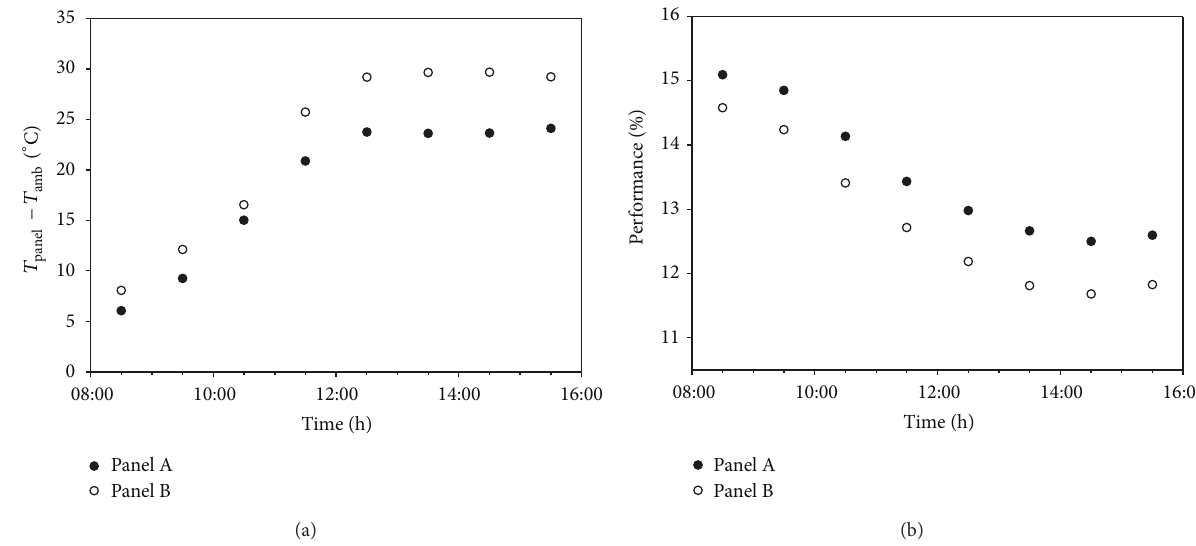
Figure 4: Comparison of the behavior between both panels, Panel A and Panel B. (a) Temperature gap between each panel and the ambient. (b) The electrical performance of each panel throughout the day.